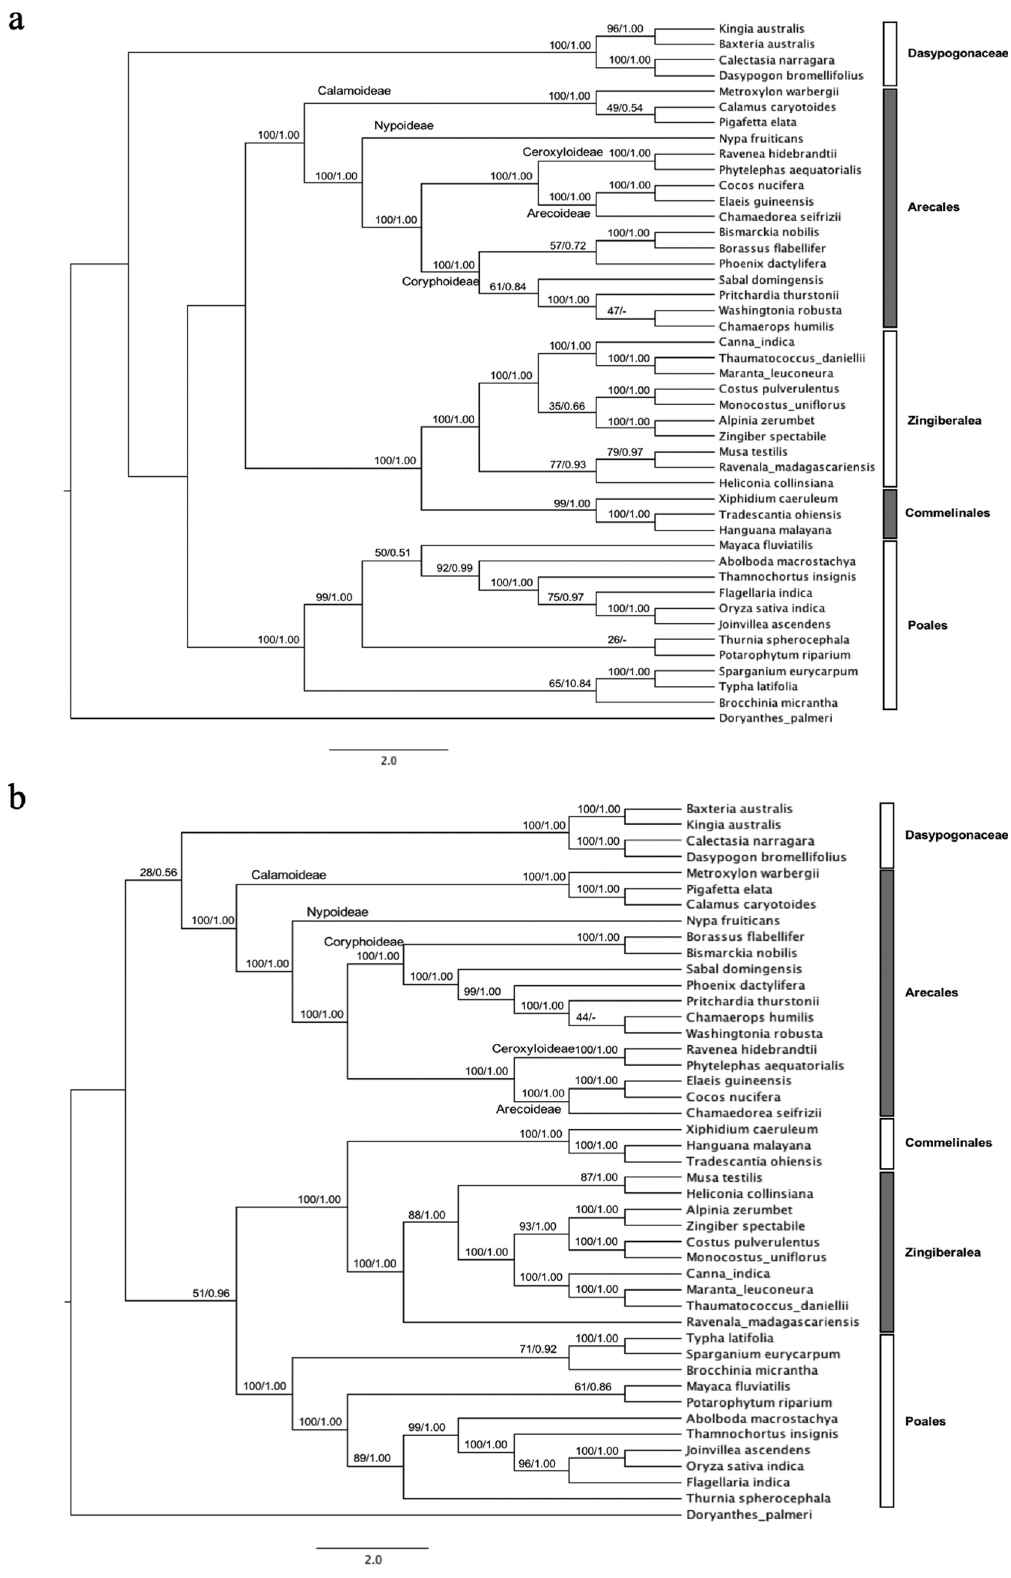
Figure 4 - Cladograms of commelinids reconstructed from seven cp genes (a) and 15 cp genes (b) based on maximum likelihood and Bayesian method with GTR+I+G model. The numbers on each branch present the bootstrap support (BP) and posterior probability value (PP), respectively. 10,000 repli- cates and 10M generations with stop value at 0.01 were applied to calculate statistical supports for maximum likelihood and Bayesian phylogeny, respec-